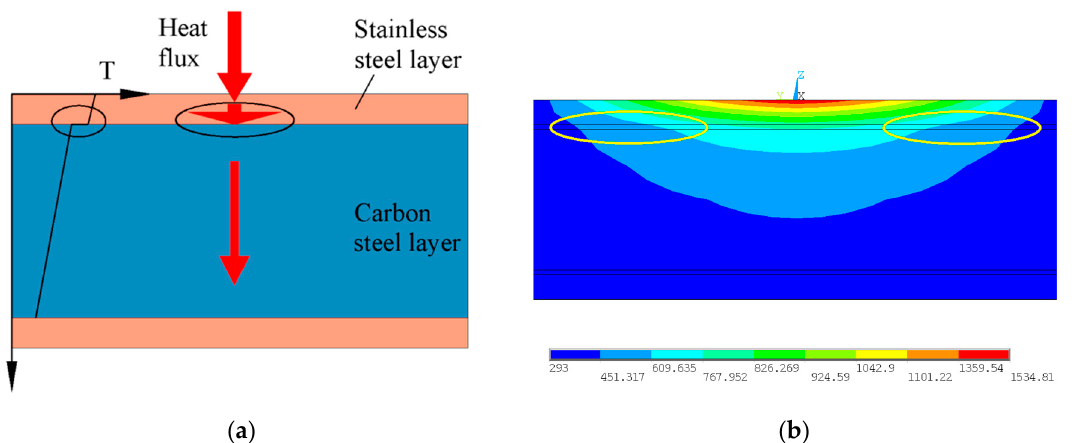
Figure 6. Temperature analysis in the thickness direction: ( a ) Heat transfer diagram at the interface; ( b ) temperature distribution in section. Materials 2019 , 11 , x FOR PEER REVIEW